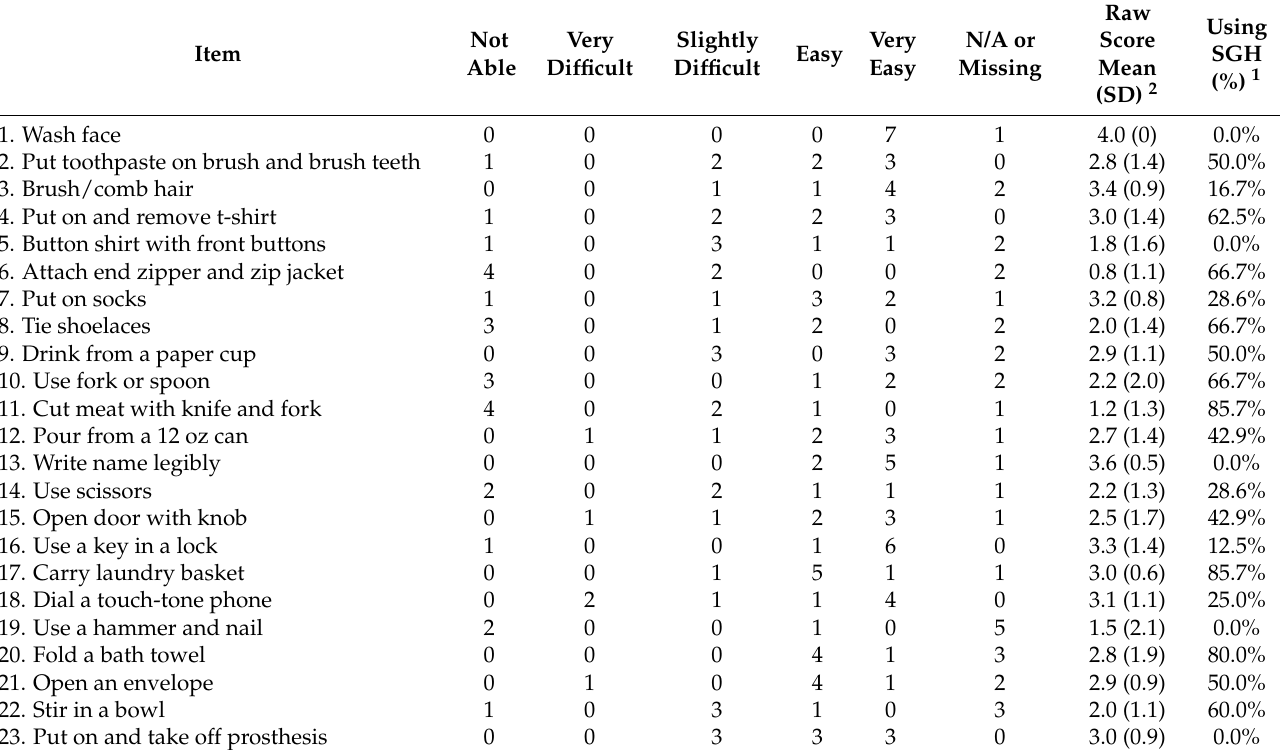
Table 2. Frequency distribution and mean values for the score of the 23 upper extremity functional status